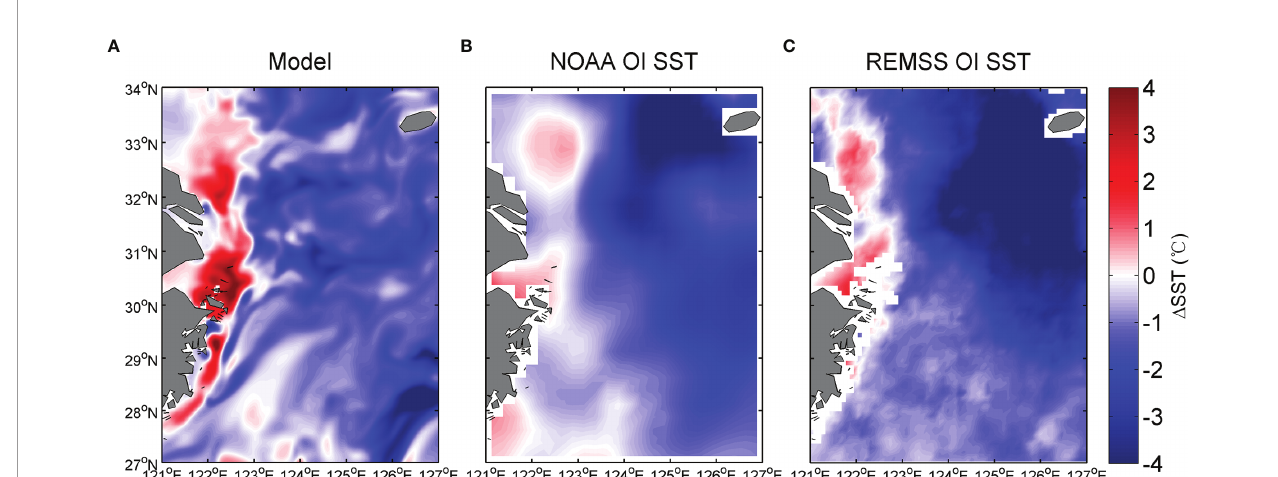
FIGURE 3 | Sea surface temperature (SST) difference ( D SST) found by subtracting daily mean SST on August 22, 2020 from that on August 28, 2020 derived from the (BYESbio24 model; (A) , US National Oceanic and Atmospheric Administration (NOAA) Optimally Interpolated (OI) SST product (B) , and Remote Sensing Systems (REMSS) OI SST product (C) .